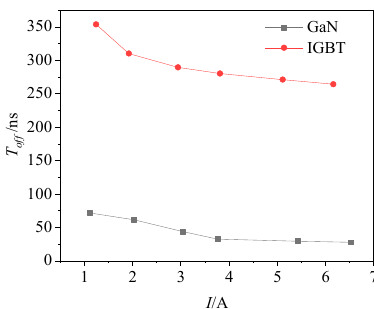
Figure 7. Experimentally measured turn-off waveform. ( a ) GaN. ( b ) IGBT.